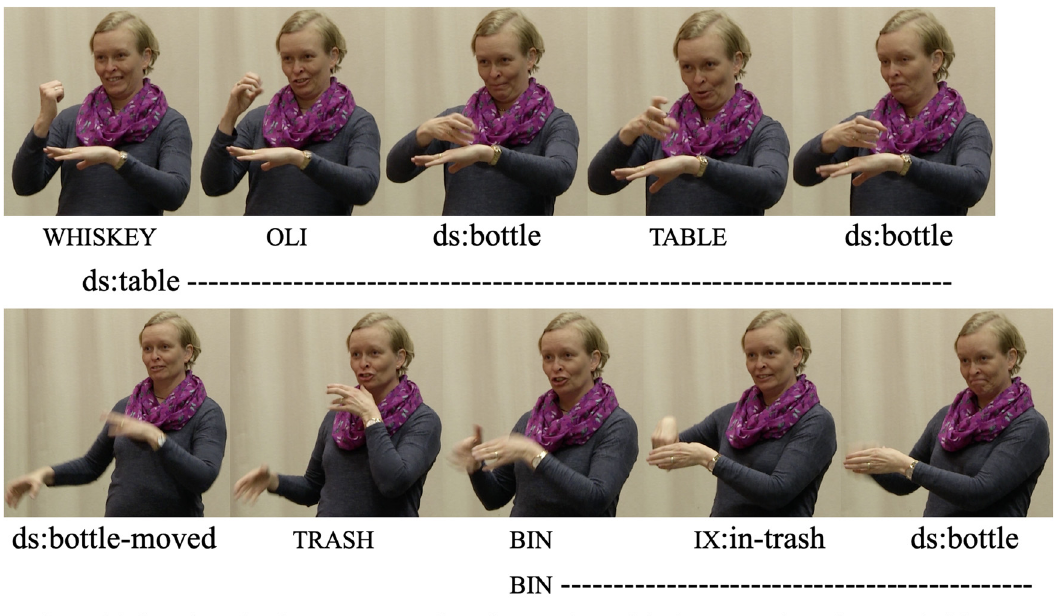
Figure 12: An example of the order Figure – OLI – Ground with known Figure depicted by means of a handling classi fi